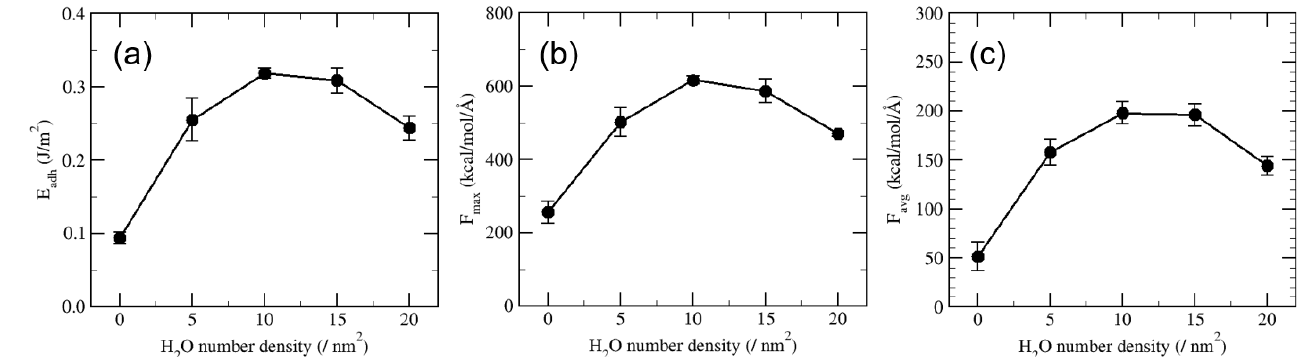
Figure 15. Change of adhesion level as a function of H 2 O number density: ( a ) adhesion energy, ( b ) maximum force, and ( c ) average force.